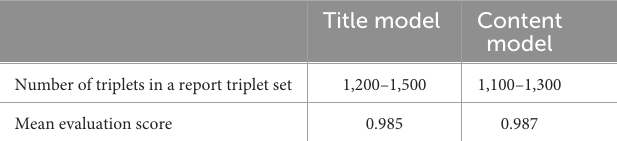
TABLE 3 Number of triplets in a report triplet set and the mean evaluation